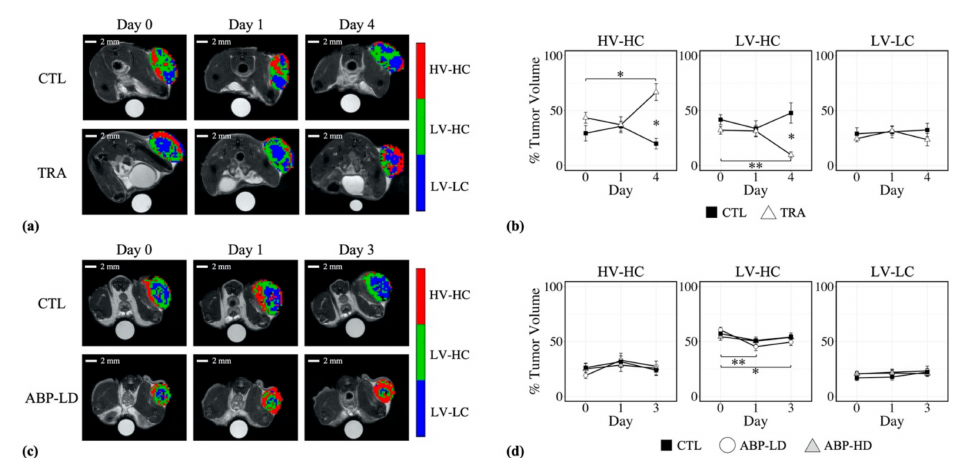
Figure 3. Panel ( a ) shows representative tumor habitat maps for a BT-474 control (CTL) and trastuzumab-treated (TRA) tumor on days 0 (pre-treatment), 1, and 4. Trastuzumab-treated tumors showed longitudinal increases in percent tumor volume (panel ( b )) of the HV-HC habitat at day 4 ( p = 0.02), and significantly higher percent tumor volumes of the HV-HC habitat compared to control ( p = 0.03). Trastuzumab-treated tumors also showed longitudinal decreases in percent tumor volume (panel ( b )) of the LV-HC habitat at day 4 ( p < 0.01) and significantly lower percent tumor volumes of the LV-HC habitat compared to control ( p = 0.03). Panel ( c ) shows representative tumor habitat maps for an MDA-MB-231 control (CTL) and low-dose albumin-bound paclitaxel (ABP-LD) tumor on days 0 (pre-treatment), 1, and 3. Low-dose ABP-treated tumors showed significant decreases in percent tumor volume (panel ( d )) of the LV-HC habitat at day 1 ( p < 0.01) and day 3 ( p = 0.01). No significant changes were observed for control and high-dose ABP (ABP-HD) tumors over the course of the study. No significant di ff erences were observed between treatment groups for the MDA-MB-231 cohort. Statistical significance is denoted with a * for p < 0.05 and ** for p < 0.01, error bars represent standard